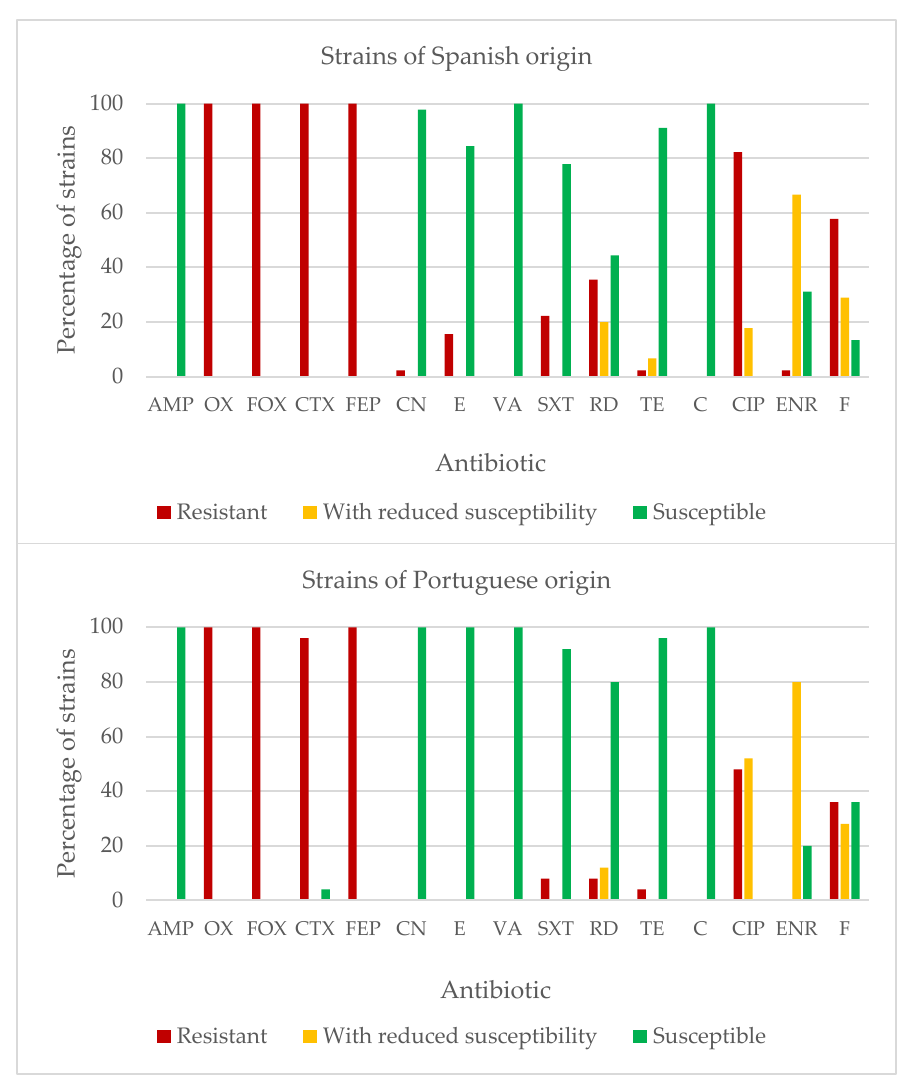
Figure 3. Percentages of strains of Listeria monocytogenes which are either resistant, have reduced susceptibility, or are susceptible to each antibiotic tested: AMP (ampicillin, 10 µg), OX (oxacillin, 1 µg), FOX (cefoxitin, 30 µg), CTX (cefotaxime, 30 µg), FEP (cefepime, 30 µg), CN (gentamycin, 10 µg), E (erythromycin, 15 µg), VA (vancomycin, 30 µg), SXT (trimethoprim-sulfamethoxazole, 25 µg), RD (rifampicin, 5 µg), TE (tetracycline, 30 µg), C (chloramphenicol, 30 µg), CIP (ciprofloxacin, 5 µg), ENR (enrofloxacin, 5 µg), and F (nitrofurantoin, 300 µg). When the strains with resistance were grouped together with those having reduced susceptibility, the prevalence was higher in Spain with regard to rifampicin ( p < 0.001), trimethoprim-sulfamethoxazole ( p < 0.01), and erythromycin ( p < 0.001). In contrast, the strains isolated in Portugal presented a greater percentage of resistance or reduced susceptibility to ciprofloxacin ( p < 0.001) than those from Spain. Figure 4 shows the percentages of reactions which are either resistant, intermediate, or susceptible for the strains from Spain and Portugal in each serogroup. Considering simul- taneously the isolates with resistance or reduced susceptibility, the average values of 48.1%, 48.6%, 46.7%, and 51.9% were observed for serogroups IIa, IIc, IVa, and IVb,